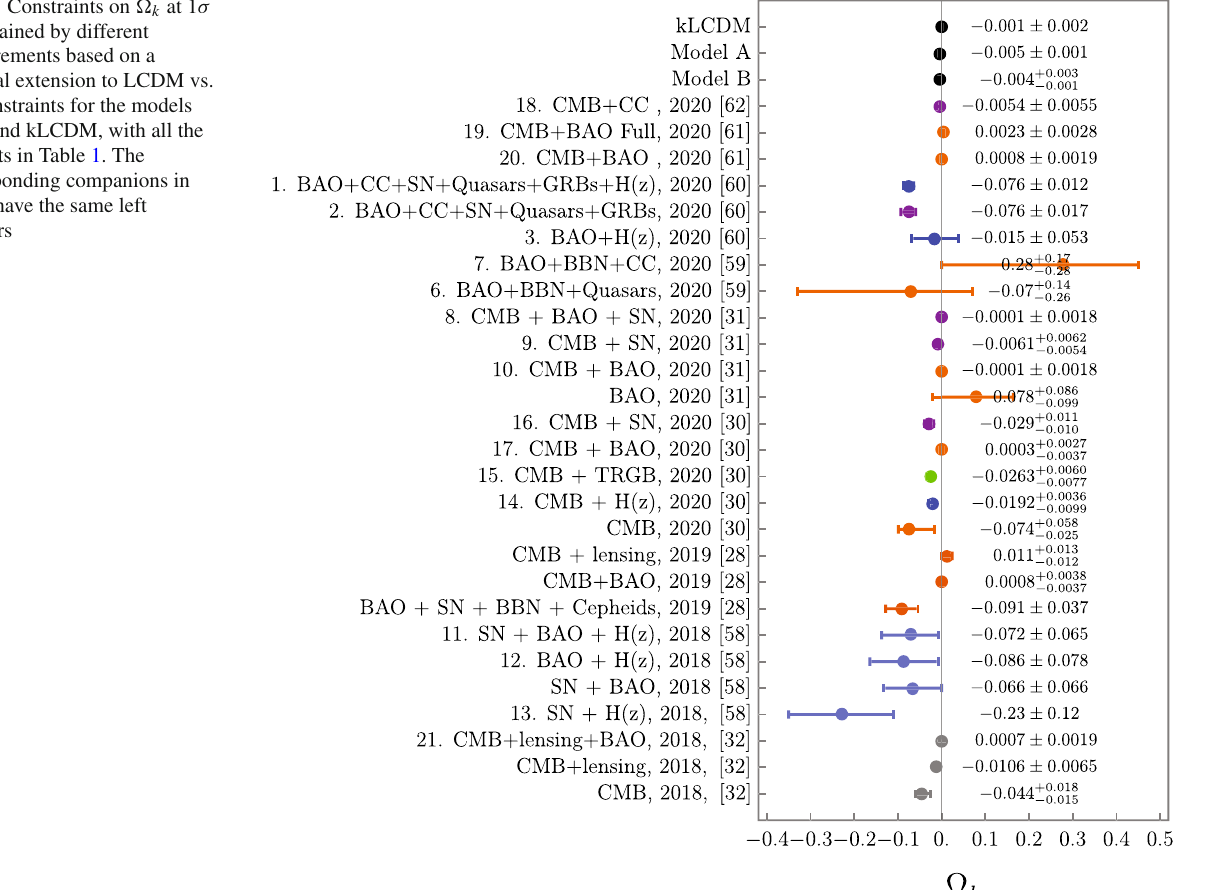
Fig. 3 Constraints on (cid:2) k at 1 σ CL obtained by different measurements based on a minimal extension to LCDM vs. our constraints for the models A , B , and kLCDM, with all the data sets in Table 1. The corresponding companions in Fig. 2 have the same